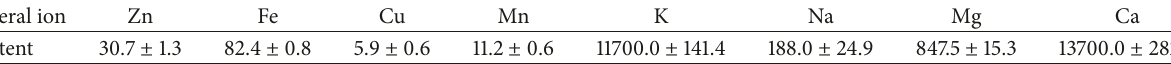
Table 3: Mineral ion composition of yellow maca cultivated in Xinjiang (mg/kg).